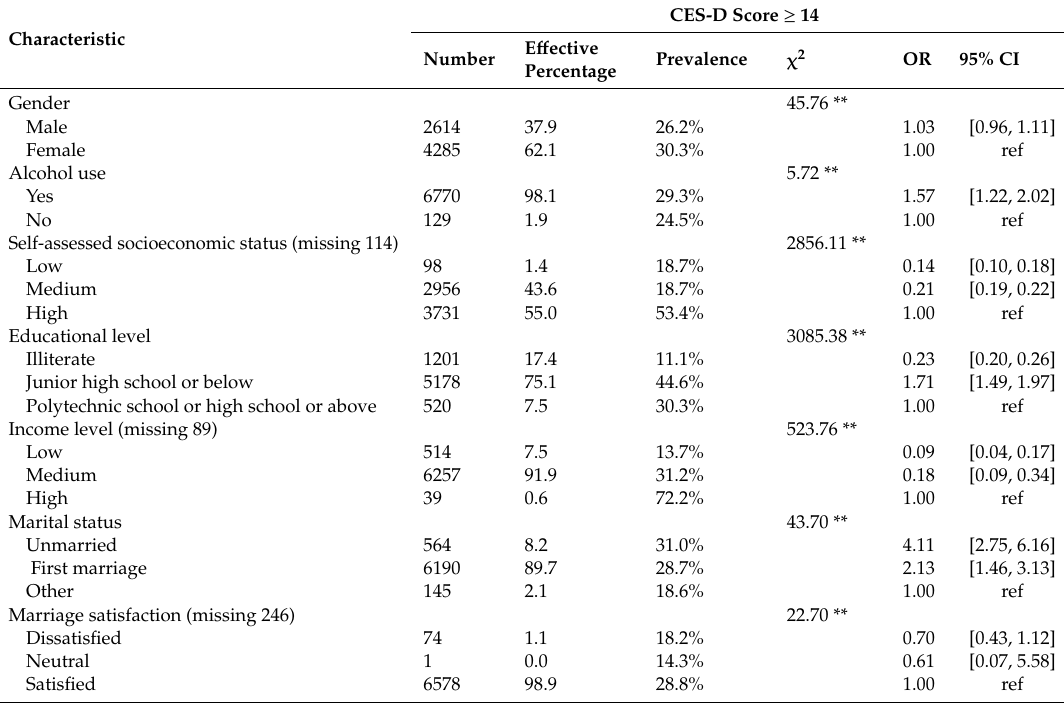
Table 3. Prevalence of depression and related demographic